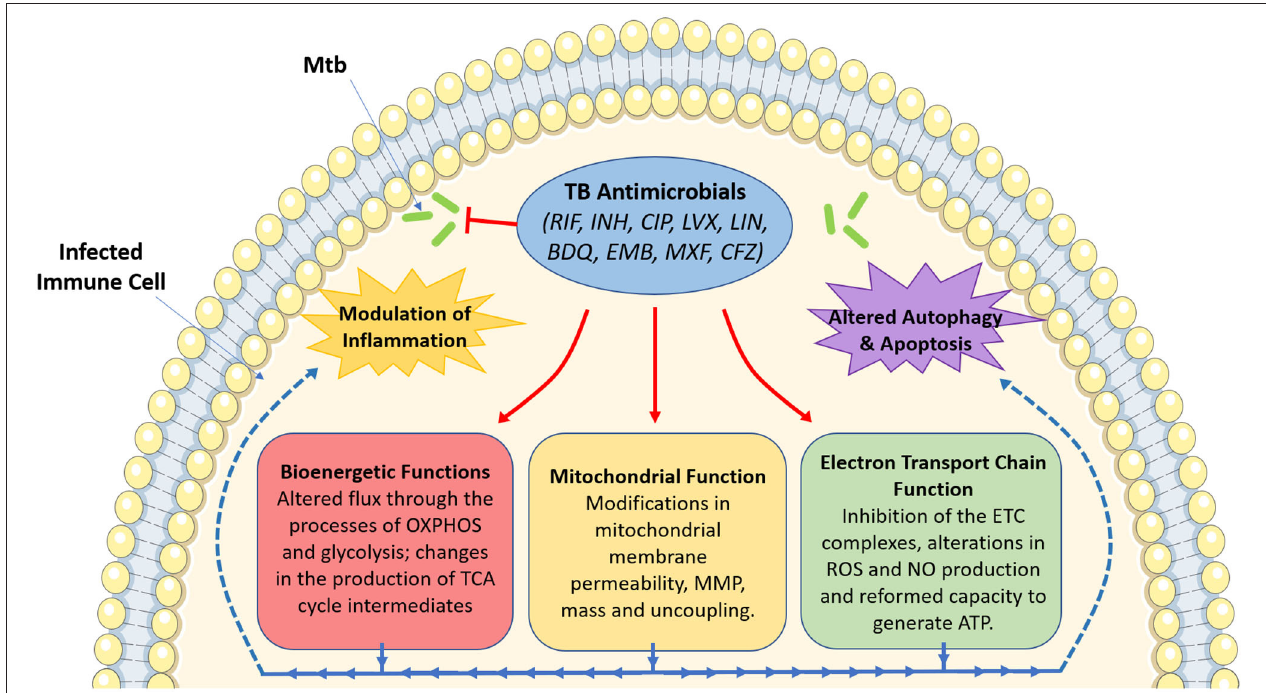
FIGURE 1 | An overview of the effect of tuberculosis antimicrobials on host mitochondrial function, bioenergetics and immune cell function. Tuberculosis (TB) antimicrobials, that are routinely used to fight TB infection, could affect a range of cellular processes, particularly mitochondrial function and various bioenergetic processes. These antimicrobials could alter MMP (isoniazid and ciprofloxacin), mitochondrial membrane permeability (rifampicin, ciprofloxacin and levofloxacin), mitochondrial mass (linezolid), or result in mitochondrial uncoupling (ciprofloxacin and levofloxacin). They could also inhibit electron transport chain complex activity (ciprofloxacin, levofloxacin, linezolid, bedaquiline, ethambutol, and rifampicin), ROS production (rifampicin and isoniazid), NO production (ciprofloxacin and levofloxacin), or ATP production (rifampicin, isoniazid and ciprofloxacin). Moreover, these antimicrobials have been shown to alter metabolic flux through OXPHOS (rifampicin, linezolid, bedaquiline, and clofazimine), glycolysis (bedaquiline, rifampicin, linezolid, moxifloxacin, ciprofloxacin, and clofazimine), while also affecting the production of TCA cycle intermediates (clofazimine). Such changes in mitochondrial function and host bioenergetics could also be linked with alterations in apoptosis (levofloxacin, ciprofloxacin, and linezolid), the autophagic process (isoniazid and bedaquiline) and a variety of inflammatory phenotypes (rifampicin, ciprofloxacin, levofloxacin, linezolid, bedaquiline, moxifloxacin, and clofazimine). Image produced with the aid of Servier Medical Art software (see copyright license at https://smart.